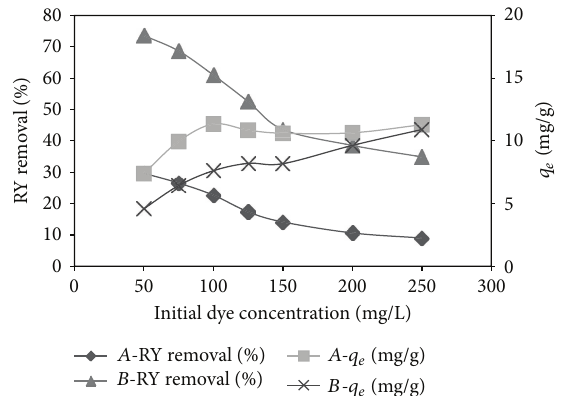
Figure 3: The pH effect for Remazol Yellow adsorption (initial dye concentration: 100mg/L, contact time: 60 min, temperature: 293 K, amount of SSCAC: 0.1g activated carbon/50 mL dye solution).